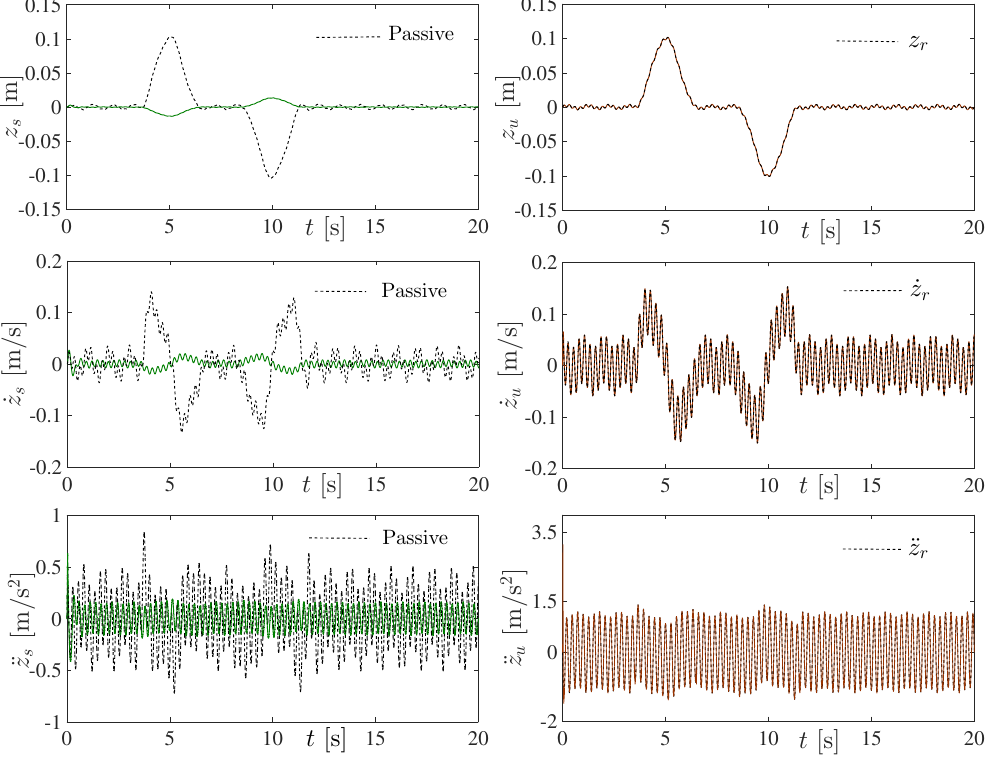
Figure 6. Responses of the active suspension system using online estimation of velocity and disturbance